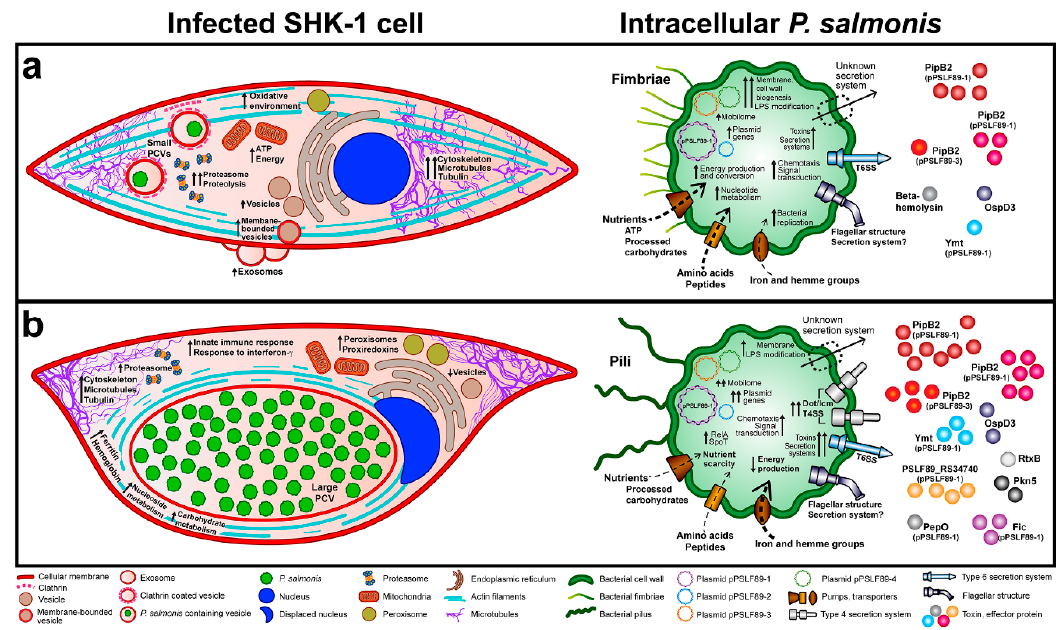
Figure 8. Schematic model of host–pathogen interaction during P. salmonis LF89 infection in salmon macrophage-like cell line. The infection model is constructed based in this work and in previous results [7,9,11,14,31–33]: the early infection stage (vacuolization) ( a ); and the late-infection stage (propagation) ( b ). ( a ) Bacteria are internalized by clathrin-dependent endocytosis. Inside the SHK-1 cell, P. salmonis highjacks the cellular metabolism, increasing energy and ATP production via glycolysis and sugar metabolism. Carbohydrates, amino acids, peptides, iron, and other nutrient transport is increased in the bacteria inside the small PCVs. The host-cell shape begins to be altered and components of vesicular systems increase. Biological quality regulation, gene expression, and cell redox homeostasis decay in SHK-1 cells, forming an oxidative environment. The bacteria respond by producing catalase, thioredoxin and chaperones. The bacteria dysregulate the host cytoskeleton, altering the actin filaments and microtubules, probably by the secretion of chromosome- and plasmid-encoded toxins. Bacteria inhibit their detection by interfering with the host cell immune response by an unknown mechanism related to toxins and T6SS effectors. ( b ) When the infection thrust forward, the size and number of intracellular vesicles increase along with the number of intracellular bacteria. As P. salmonis replicates inside large cytoplasmic vacuoles, the nutrient transport to the bacterial cytoplasm decrease, and the stringent response is triggered. Iron becomes limited, different iron acquisition proteins increase in P. salmonis , while iron-transporting proteins are found in SHK-1 cells. General nucleotide, nucleoside, and ribonucleotide metabolic and biosynthetic processes increase in both P. salmonis and host cells. Propagation stage host cells detects the bacterial pathogen and elicits an immune response via interferon- γ . The expression of Dot/Icm T4SS genes, toxins, and effector proteins increases in P. salmonis , together with plasmid genes, mobilome, transposons, and phage-related proteins. The increase expression of secretion system proteins, toxins, and effector proteins suggests the bacteria is preparing to exit the cell (by a yet unknown mechanism) moving forward to the detachment stage of infection, as depicted in Figure 1g. Supplementary Materials: The following are available online at www.mdpi.com/xxx/s1, Figure S1: Schematic representation of sample pools obtained for global proteomic profiling of P. salmonis infections in SHK-1 cultures, Table S1: P. salmonis LF-89 and S. salar SHK-1 cells quantitative proteomics results, Table S2: Primers used for qPCR analyses, Table S3: Enrichment analyses of S. salar proteomic results, Table S4: qPCR analysis of P. salmonis selected virulence factors.